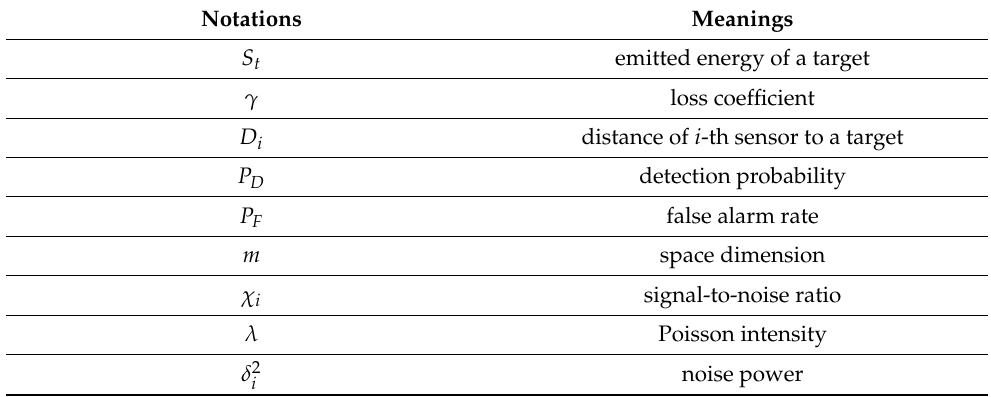
Table 1. Notation of